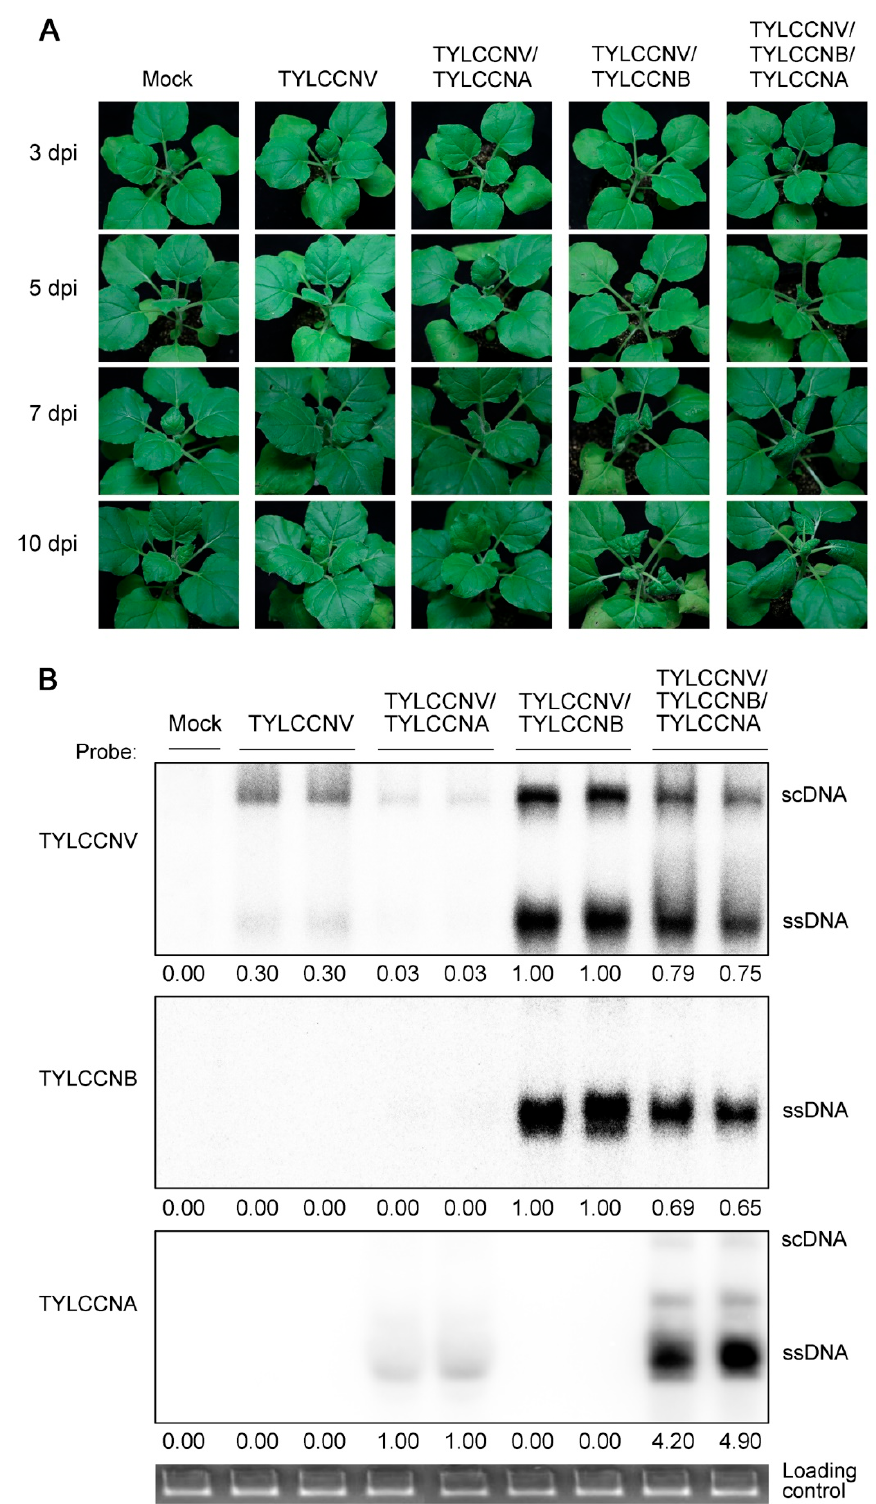
Figure 1. Symptoms and viral DNA accumulation in N. benthamiana plants during virus infections. ( A ) Disease symptoms induced by tomato yellow leaf curl China virus (TYLCCNV) alone, TYLCCNV/alphasatellite (TYLCCNA), TYLCCNV/betasatellite (TYLVVNB) or TYLCCNV/TYLCCNB/TYLCCNA in N. benthamiana seedlings at 3, 5, 7 and 10 days post-inoculation (dpi). Mock-inoculated with pBINPLUS was used as the control. ( B ) TYLCCNV, TYLCCNB and TYLCCNA genomic DNA levels in N. benthamiana seedlings infected with TYLCCNV, TYLCCNV/TYLCCNA, TYLCCNV/TYLVVNB, TYLCCNV/TYLCCNB/TYLCCNA or pBINPLUS at 7 dpi are shown in Figure 1A. Total genomic DNA (approximately 10 μ g for each lane) from a mixture